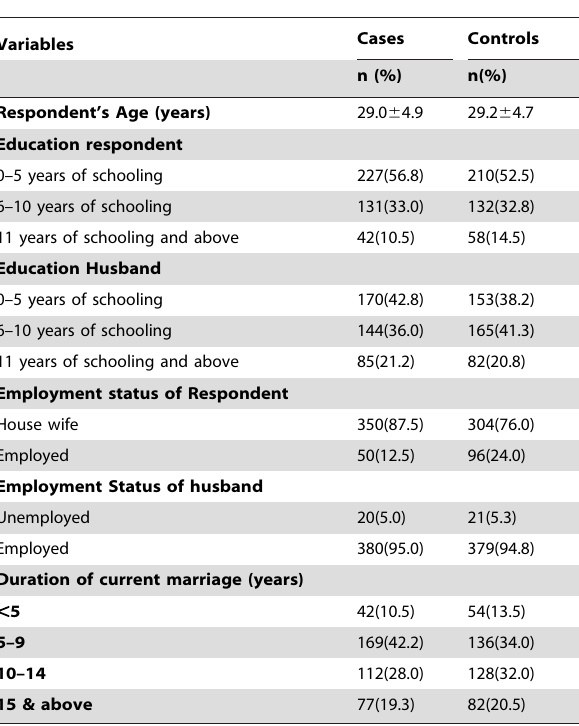
Table 1. Socio-Demographic characteristics of cases (n=400) and matched controls (n =400) studied for their association with secondary infertility in Karachi,